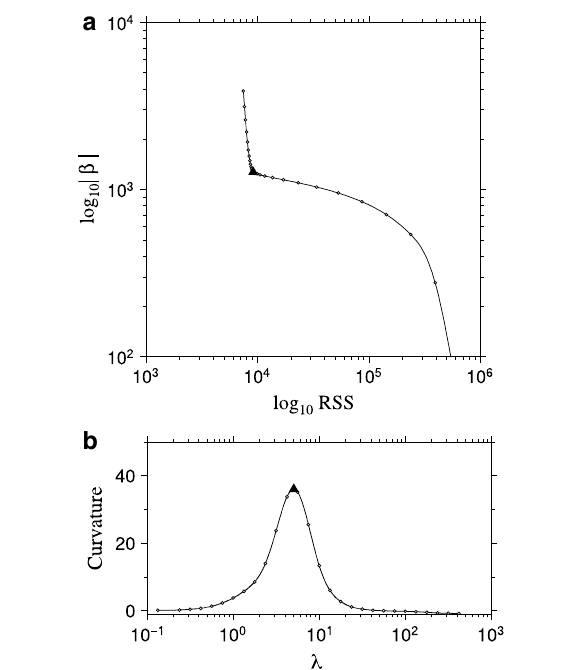
Fig. 4 L-curve and its curvature. a An L-curve obtained by CDA for L1 norm regularized magnetic inversion. The open circles are the discrete L-curve obtained by CDA for a decreasing sequence (cid:31) down 10 3 to (cid:31) min 10 − 1 with an interval of log 10 (� (cid:31) ) from (cid:31) max = = on the log scale. The solid line is the interpolation curve of the discrete L-curve obtained by cubic spline. b The curvature of the interpolated L-curve. The solid triangles of these figures show the point where the curvature of the interpolated L-curve takes maximum